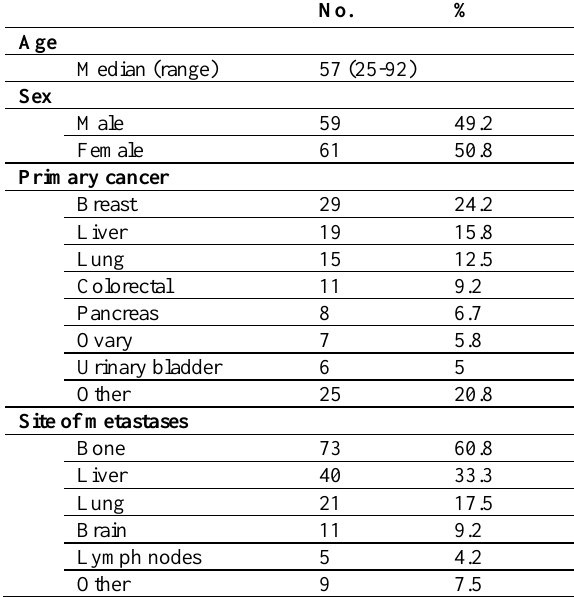
Table 1: Patients’ characteristics